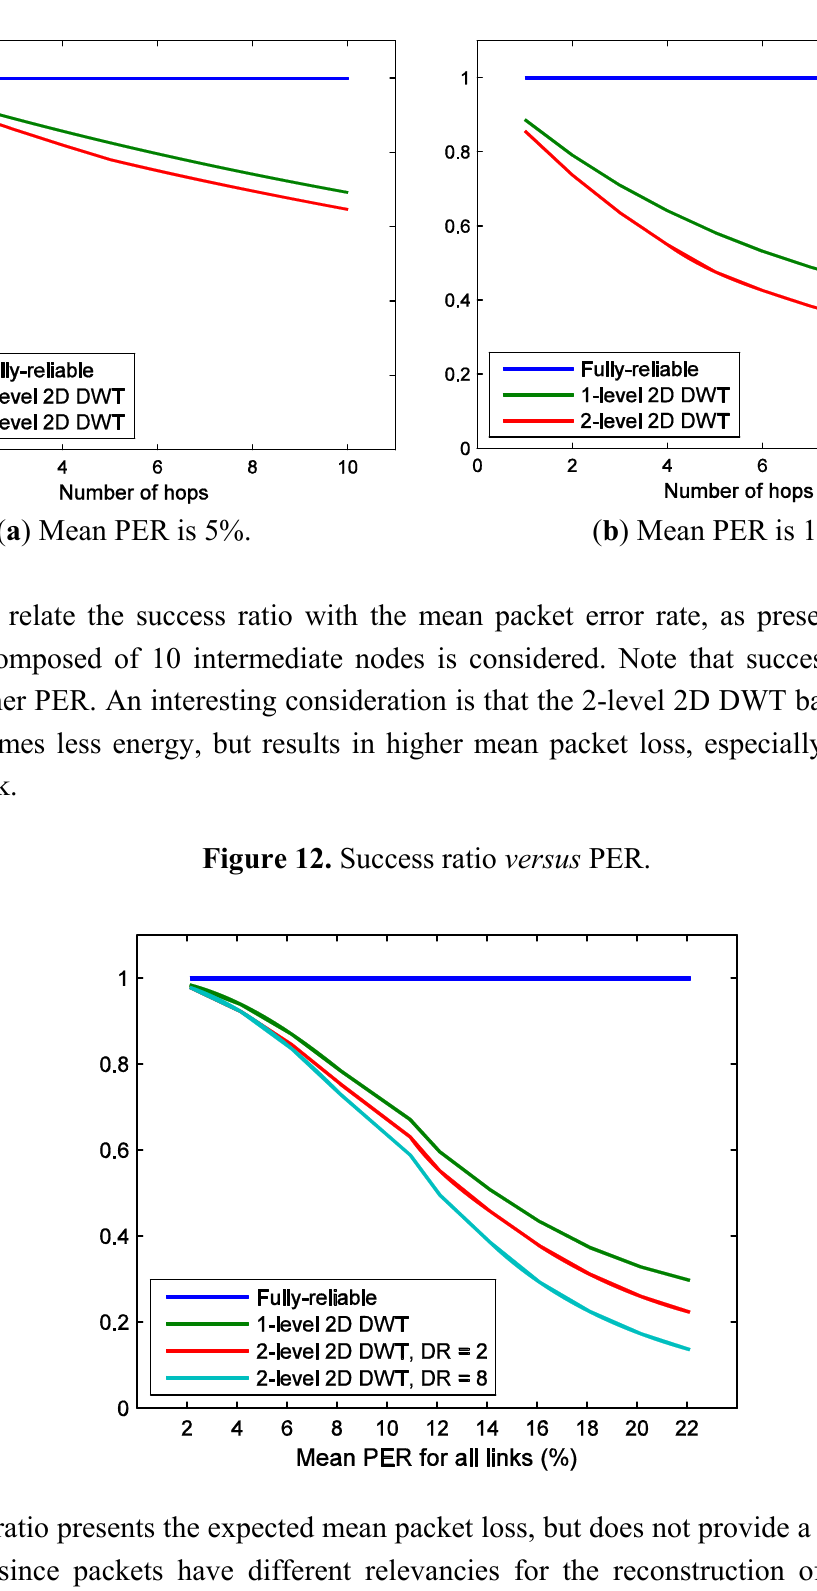
Figure 11. Success ratios for different mean packet error rates.